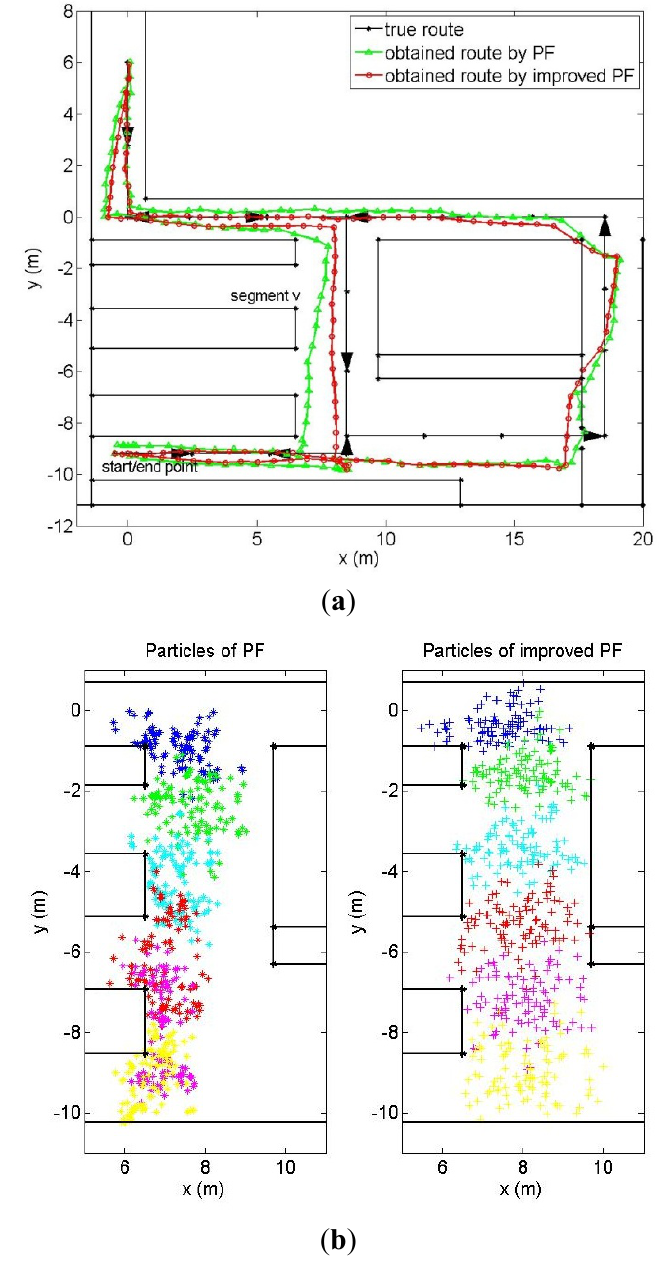
Figure 6. Performance comparison of PF and the improved